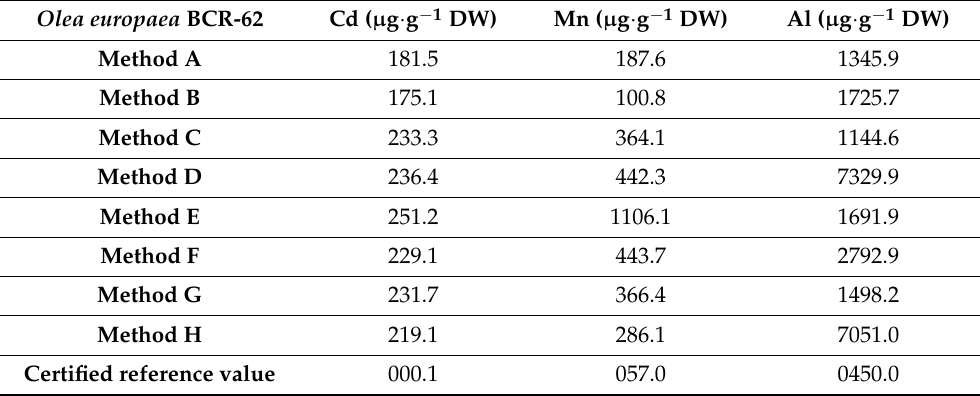
Table 3. Comparison of results obtained using tested digestion methods with certified reference values in Olea europaea